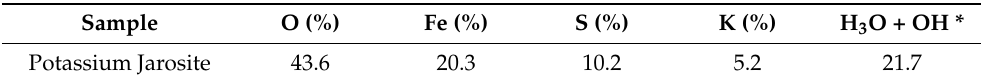
Table 2. Average punctual chemical analysis of potassium jarosite synthesized at 75 ◦ C for 9 h (SEM-EDS). Sample Potassium